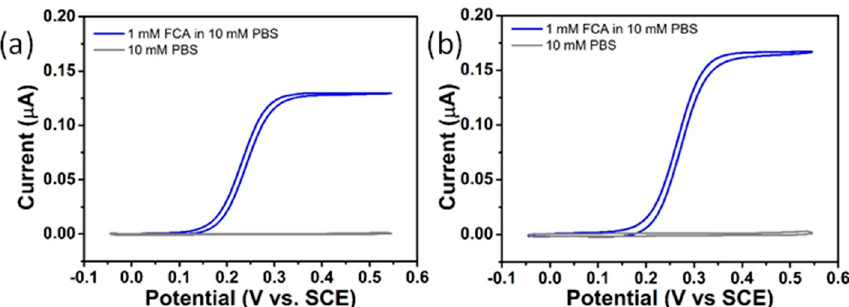
Figure 4. Typical CVs obtained for 1 mM FCA in 10 mM PBS (blue line) and in 10 mM PBS (grey line) at 10 mVs − 1 at ( a ) gold microdisc array electrode and ( b ) NPG-modified microdisc array